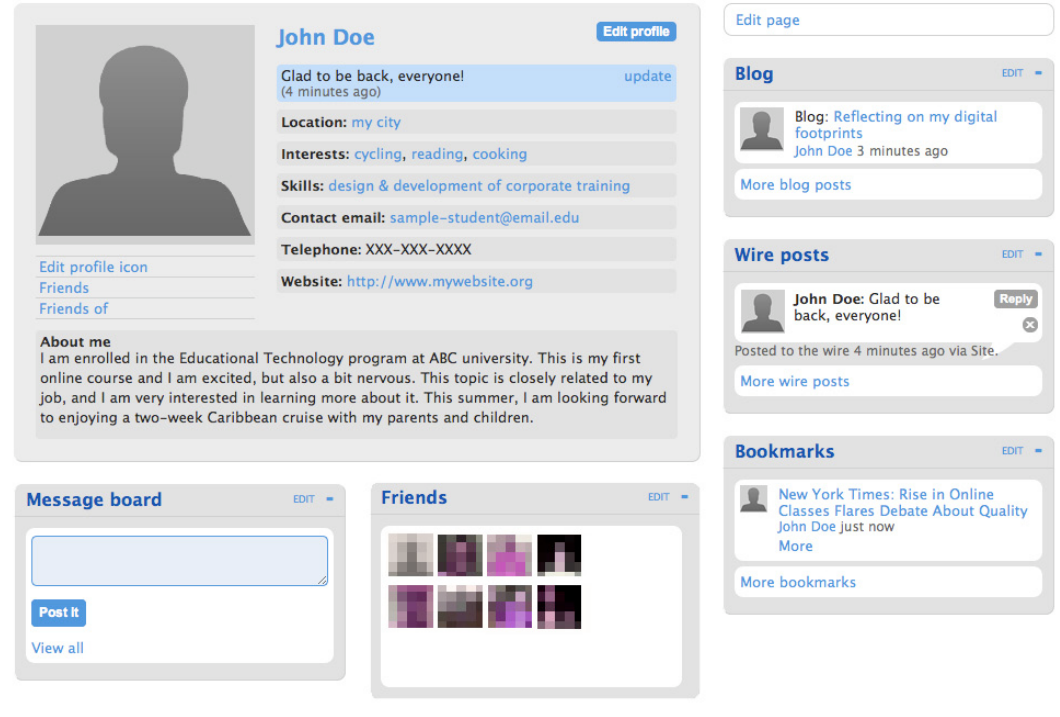
Figure 2 . Student